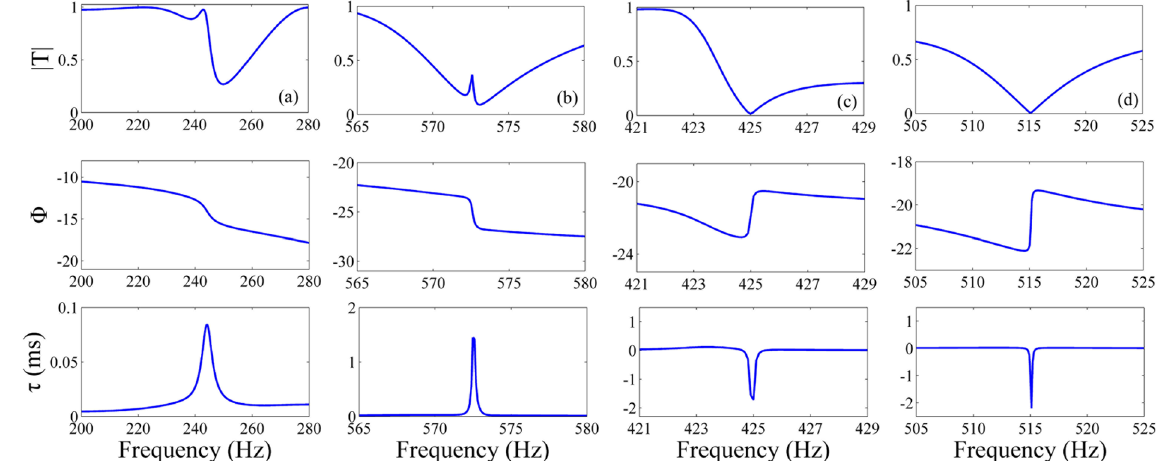
Figure 5. Theoretical transmissions and phase times in a three-ordered QKCM. Theoretical transmissions and phase times in the vicinities of ( a ) 243 Hz, ( b ) 573 Hz, ( c ) 425 Hz and ( d ) 515 Hz obtained in a metamaterial with the shape resembling a three-order Koch curve, in which the side length of the largest triangle is 120